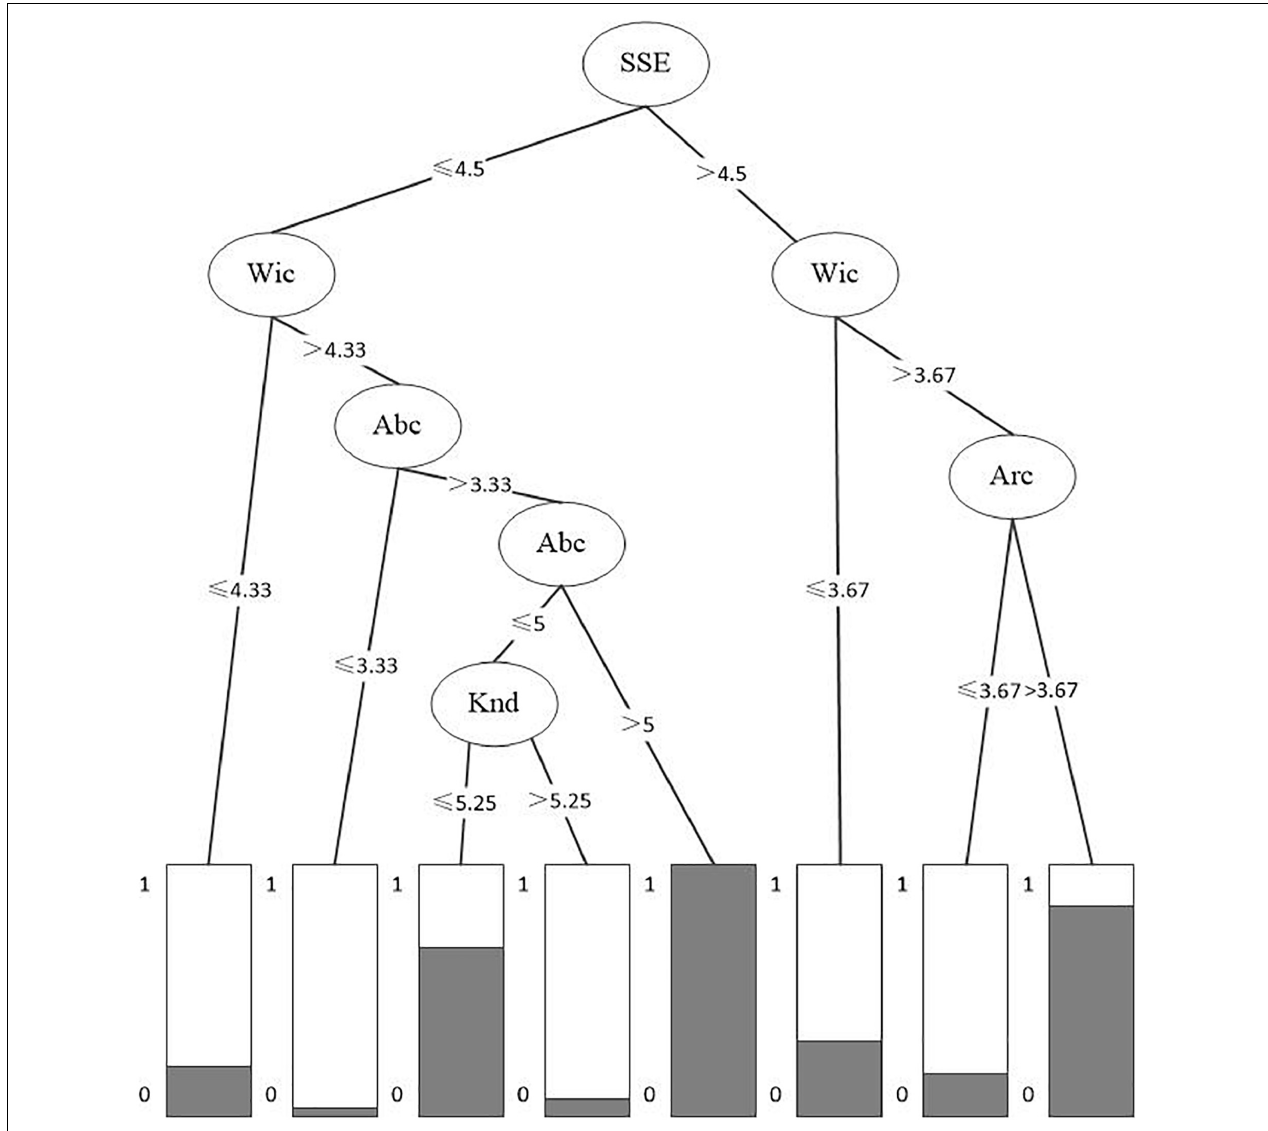
FIGURE 3 | Decision tree prediction model results.